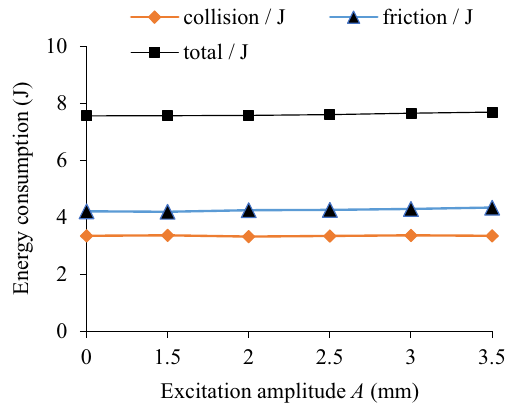
Figure 15. Influence of A on TEC.